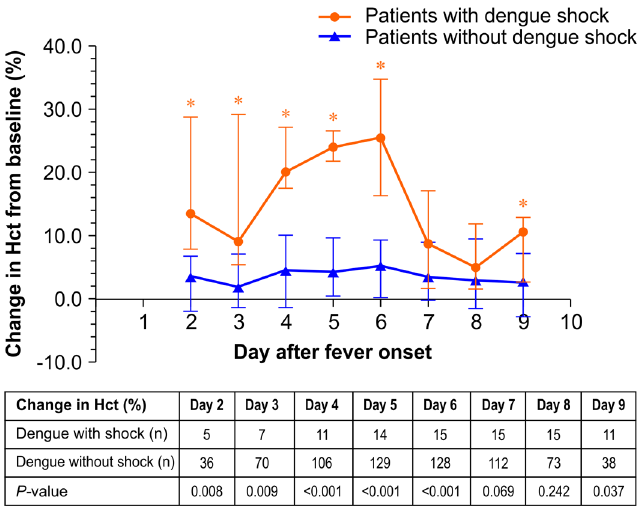
Fig 2. Change in hematocrit (Hct) from baseline (%) by day after fever onset among patients with and without dengue